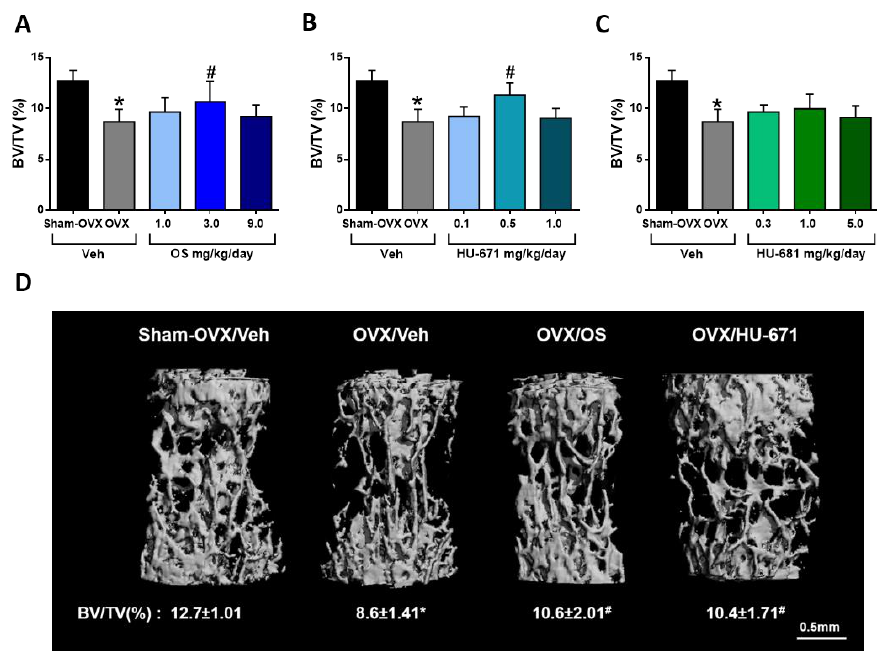
Figure 4. Microstructural analysis of trabecular bone in L3 vertebral bodies of OVXed mice treated with OS and its methylated derivatives. L3 trabecular bone volume density (BV/TV) values of OS- ( A ), HU-671- ( B ), and HU-681- ( C ) treated animals. Representative 3D images of the L3 vertebrae of mice with median BV/TV values for each treatment ( D ). Data represent the means ± SDs obtained from 7 – 9 mice per condition. * p < 0.05 versus the Sham-OVX/Veh-treated group, # p < 0.05 versus the OVX/Veh-treated group.